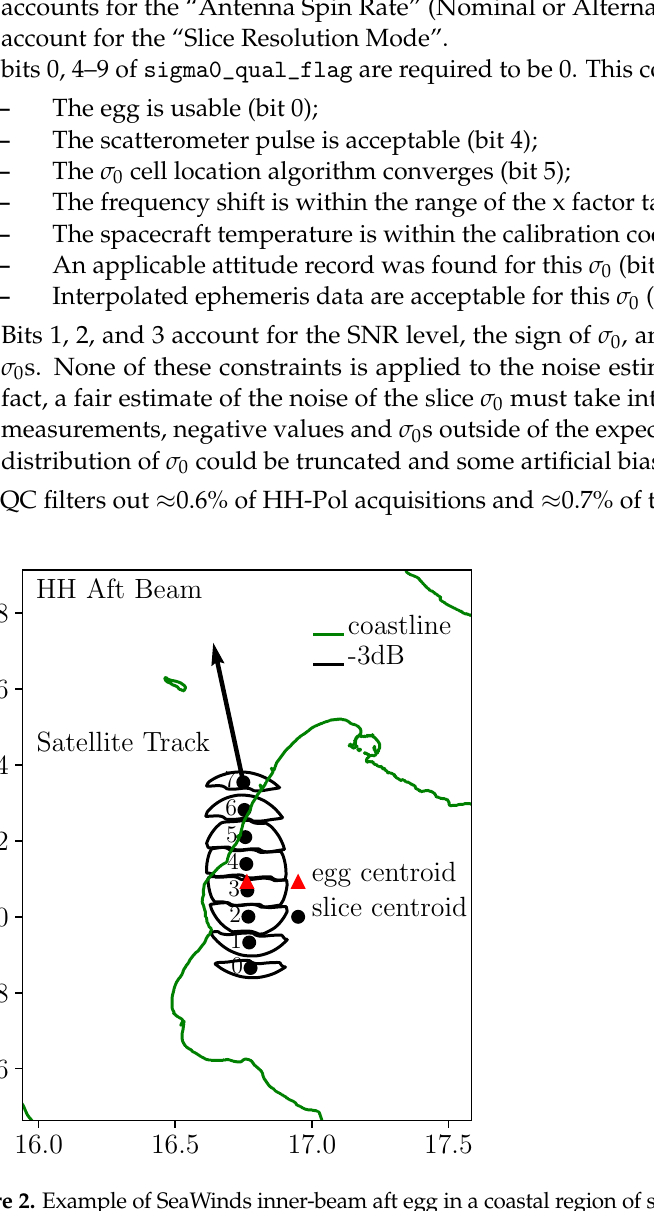
190°. The 3 dB contours of the slice ≈ −